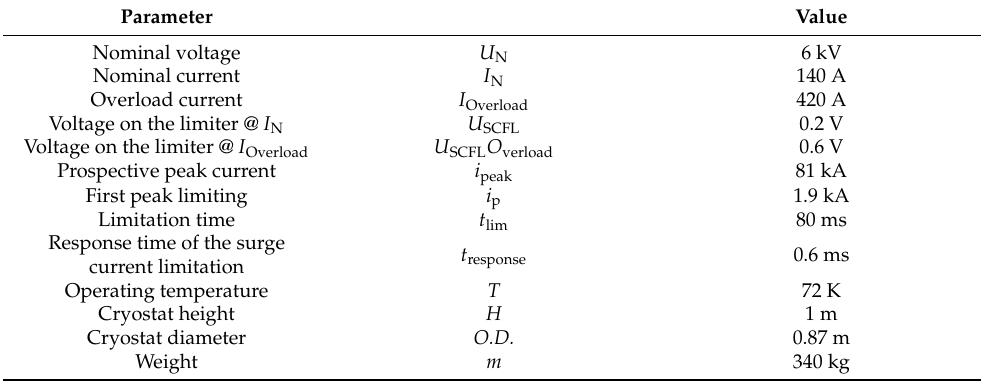
Table 1. Parameters of the SFCL.